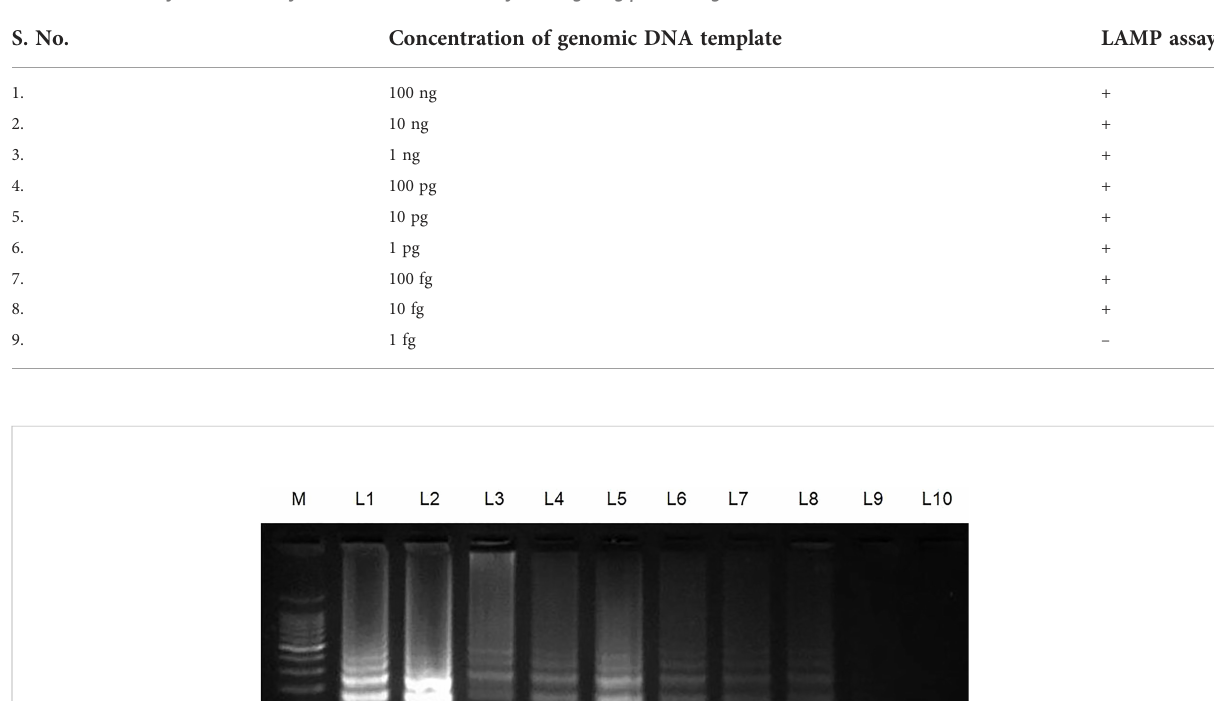
The values (bold) indicated optimal reagents concentrations selected for LAMP assay.